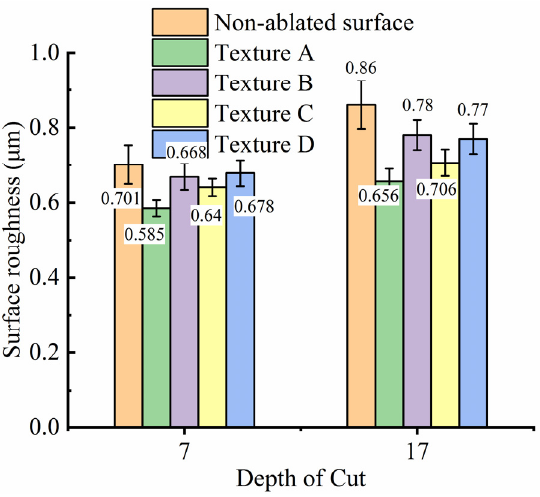
Figure 10. Surface roughness with different